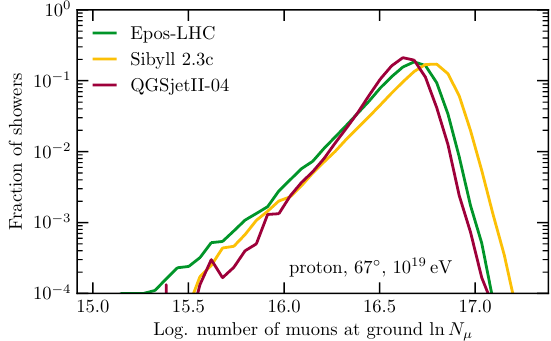
Figure 1. Distribution of the number of muons at ground in sim- ulated extensive air showers induced by protons with an energy of 10 19